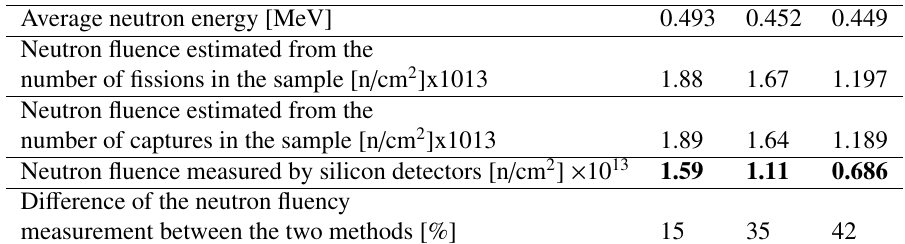
Table 3. Compilation of neutron fluencies measured by two methods for three experiments in terms